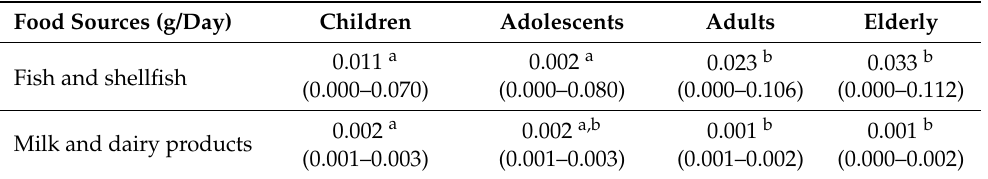
Table 15. Contribution of dietary food sources to eicosapentaenoic acid (EPA) intakes per age group among the ANIBES Study